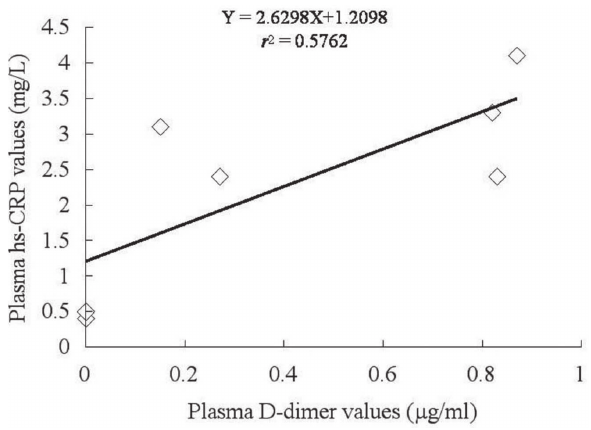
Fig. 6. Linear correlation between plasma D-dimer and plasma hypersensitive C-reactive protein levels of the aortic aneurysm group